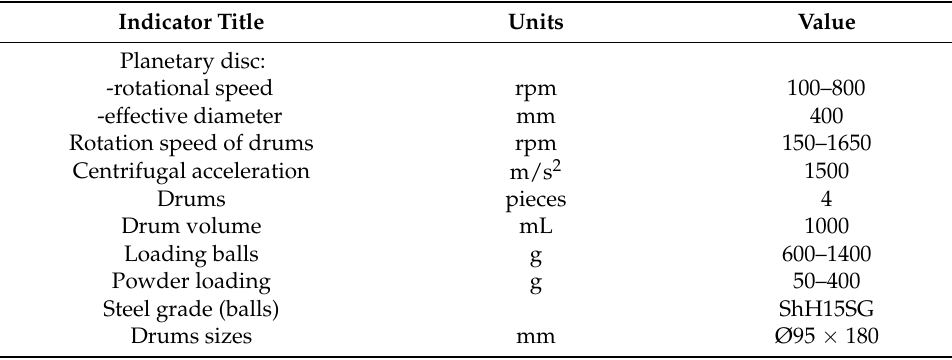
Table 8. Technical characteristics of